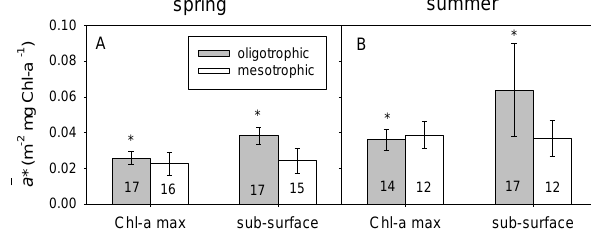
Table 1. Spearman rank-order correlation coefficients of sea surface temperature (SST) and density differences in the upper 200m (density) for nitrate (N) and inorganic phosphate (P) concentration in the potential euphotic zone (0–125m). Data are shown for spring and summer cruises ( n = 32) and for stratified ( n = 52) and non-stratified ( n = 12) stations from both cruises combined. Significant correlations are bold. Summer Spring Stratified Non-stratified SST Density SST Density SST Density SST Density N (0–125m) − 0.99 − 0.87 − 0.99 − 0.75 − 0.84 Fig. 3. The spectrally weighted mean specific absorption coefficient ( ā* ) for the chlorophyll maximum (Chl a max ) and sub-surface samples for oligotrophic and mesotrophic stations, obtained during the spring (A) and summer (B) cruises (average ± standard deviation). The number of replicates is indicated in the bars. Significant differences between chlorophyll maximum and sub-surface samples are indicated with *.